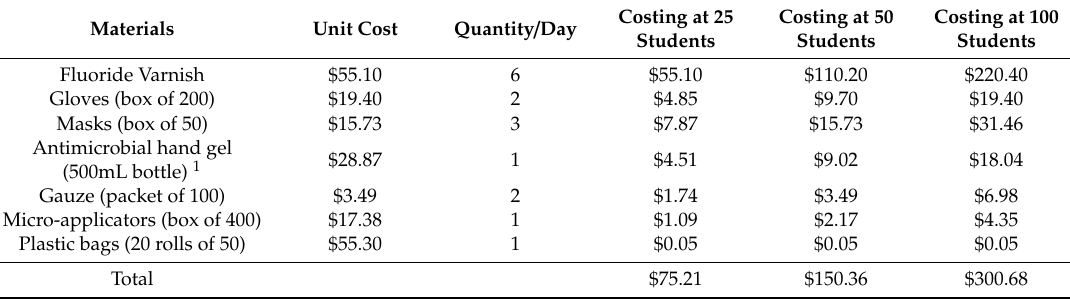
Table 3. Estimated costs of materials for the school-based fluoride varnish program.